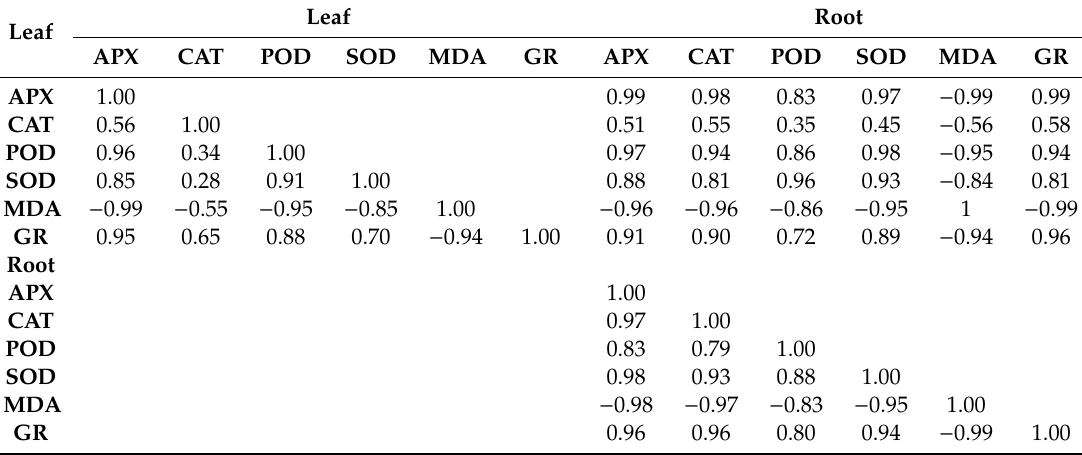
Table 1. Correlation analysis of superoxide dismutase (SOD), peroxidase (POD), catalase (CAT), malondialdehyde (MDA), ascorbate peroxidase (APX), and glutathione reductase (GR) content in the leaves and roots of five pistachio rootstocks.